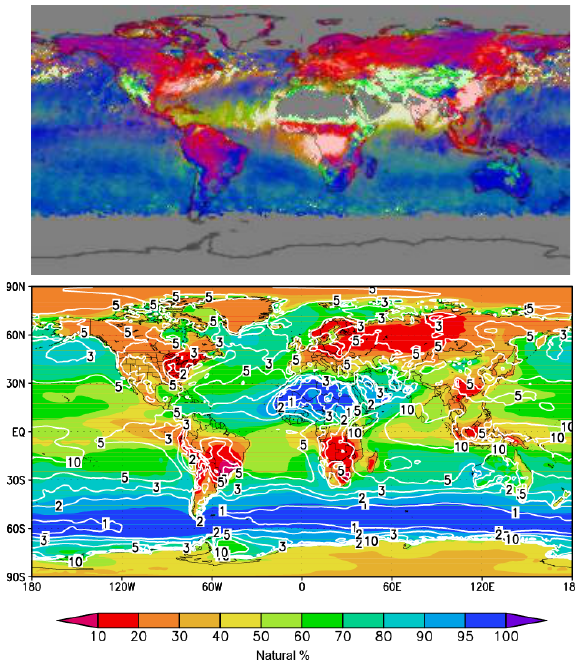
Fig. 14. (a) This false color image is a map of natural aerosols (green pixels), human pollution (red pixels), or a mixture of both (light brown pixels). Gray areas indicate a lack of usable data. This map covers pollution measured between January 2001 and July 2002. (b) Global distribution of the averaged percentages of natural aerosol contributions to total aerosols (shading) with the standard deviations (contour lines) of the percentages from the 10 yr model-